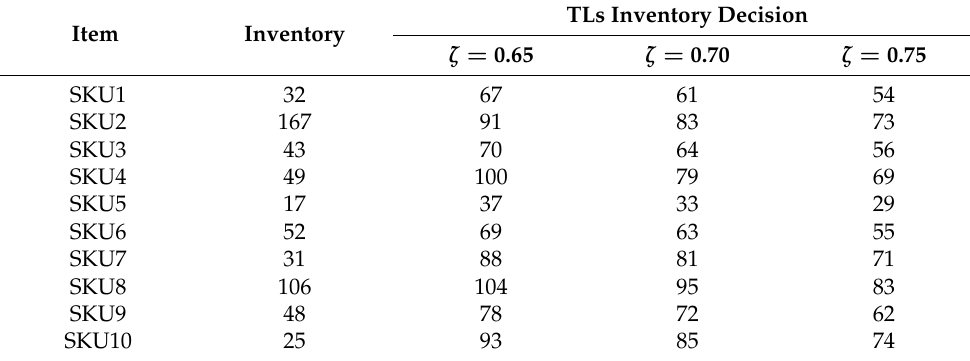
Table 6. TLs inventory decision for the SKUs in shoes cluster